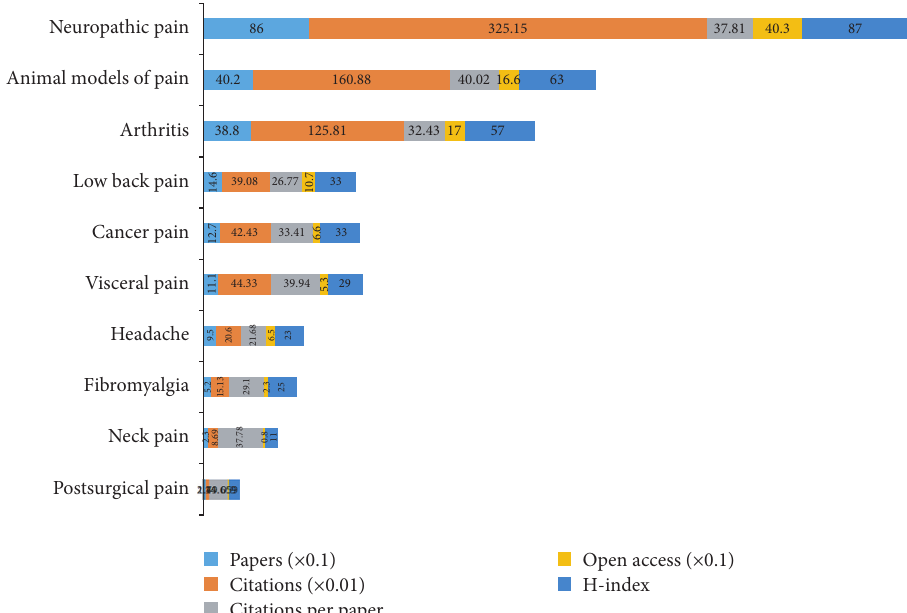
Figure 5: Number of papers, citations, citations per paper, open access papers, and H-index of the top 10 types of